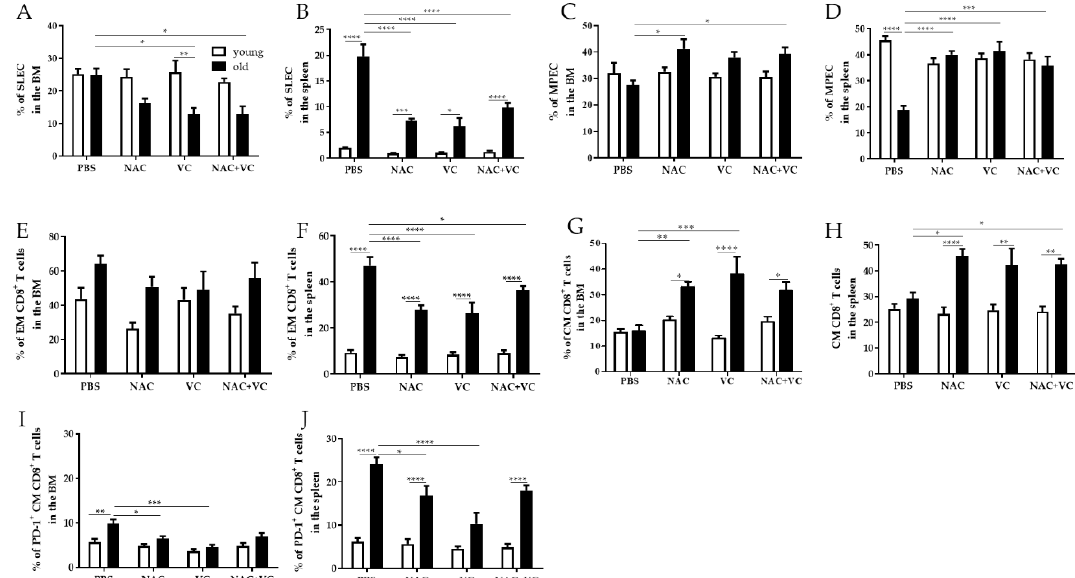
Figure 3. Effector/memory CD8 + T cell subsets in the BM and in the spleen. Frequency of ( A ) SLEC in the BM, ( B ) SLEC in the spleen, ( C ) MPEC in the BM, ( D ) MPEC in the spleen, ( E ) EM CD8 + T cells in the BM, ( F ) EM CD8 + T cells in the spleen, ( G ) CM CD8 + T cells in the BM, ( H ) CM CD8 + T cells in the spleen, ( I ) PD-1 + CM CD8 + T cells in the BM, ( J ) PD-1 + CM CD8 + T cells in the spleen of young (white columns) and old (black columns) mice treated with PBS, NAC, Vc, or NAC + Vc. Data are shown as mean ± SEM. Two-way ANOVA, Tukey post-hoc test. * p < 0.05; ** p < 0.01; *** p < 0.001; **** p < 0.0001.